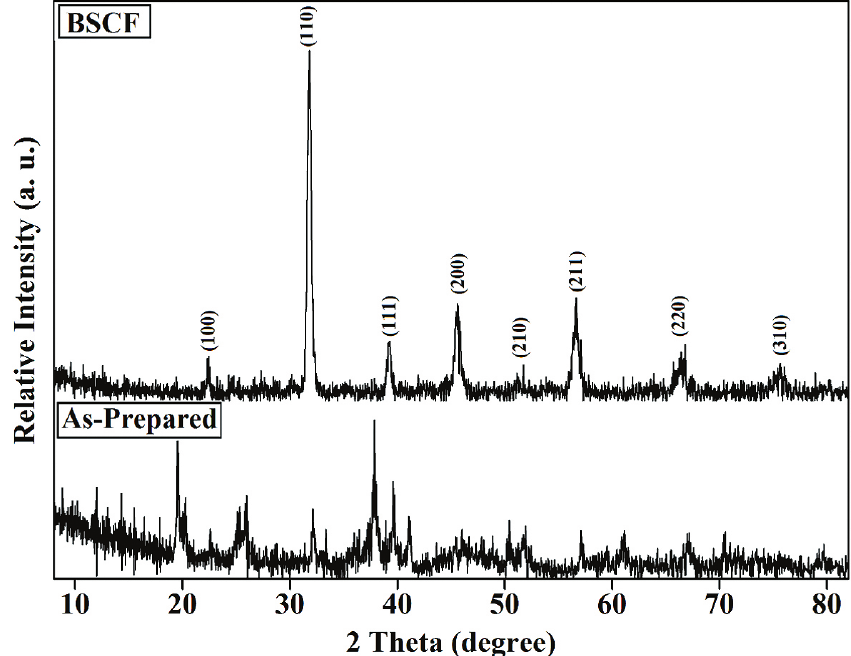
Figure 1. XRD patterns of as-prepared powder and BSCF powder after heat treatment at 900 o C.